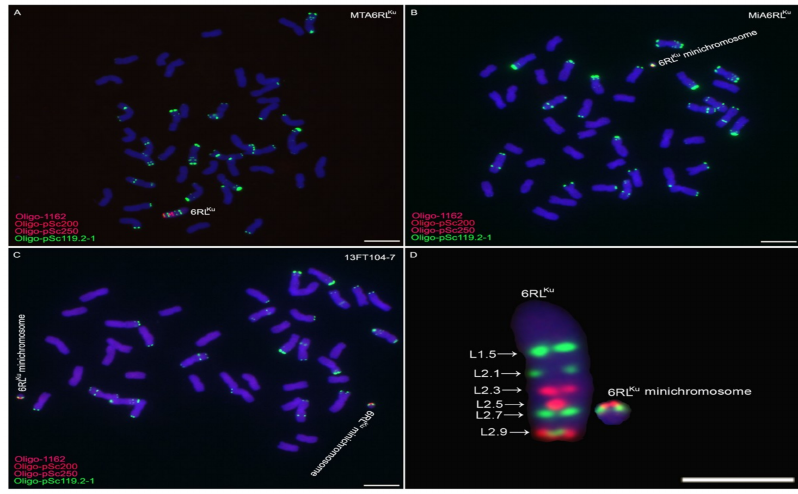
Figure 1. ND-FISH analysis of MTA6RL Ku and MiA6RL Ku . ( A , B , C) Oligo-1162 ( red ), Oligo-pSc200 ( red ), Oligo-pSc250 ( red ), and Oligo-pSc119.2-1 ( green ) were used as probes. ( D ) Cut and pasted 6RL Ku from MTA6RL Ku and 6RL Ku minichromosome from 13FT104-7. The FISH map